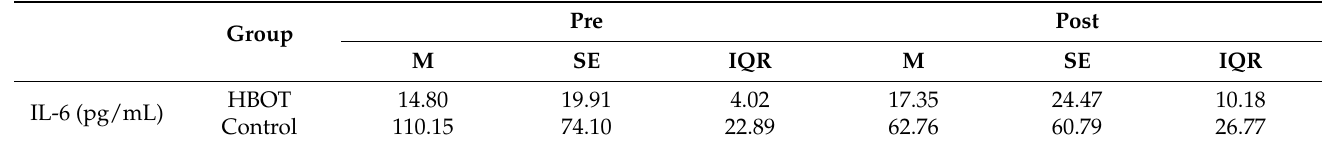
Table 5. IL-6 levels at treatment onset and at the final measurement.